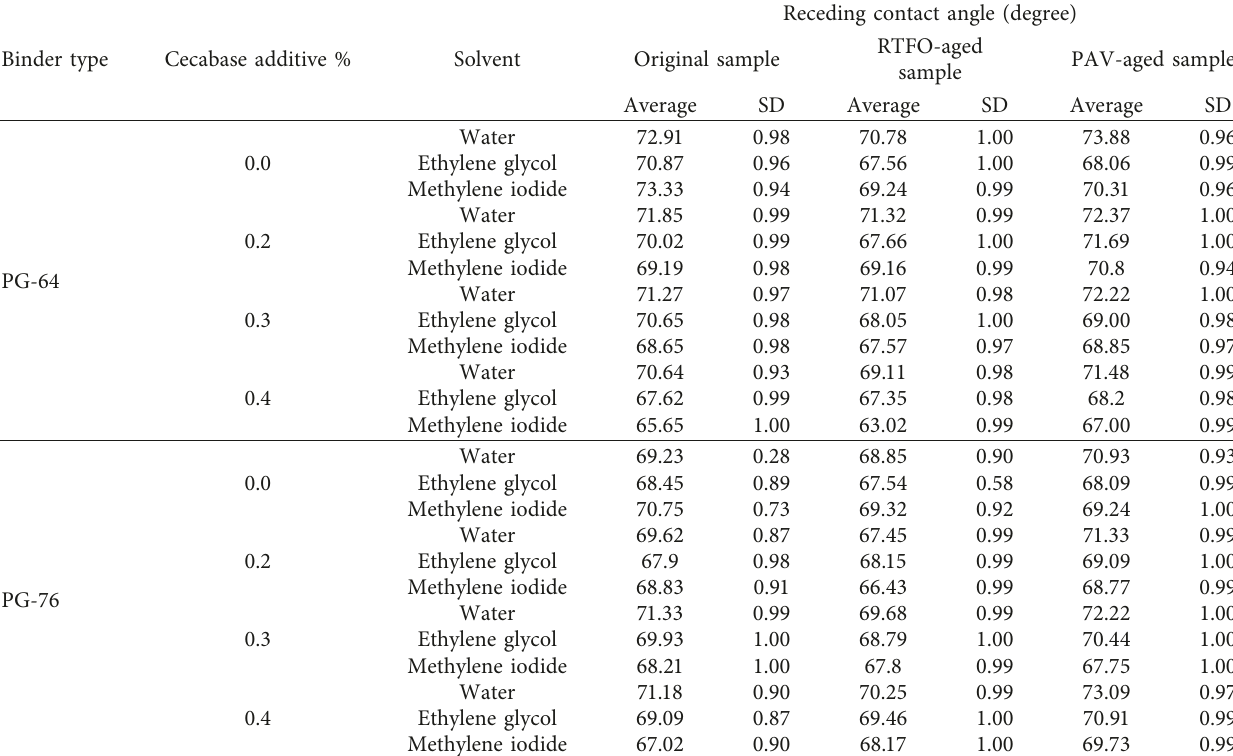
Table 6: Receding contact angle of asphalt